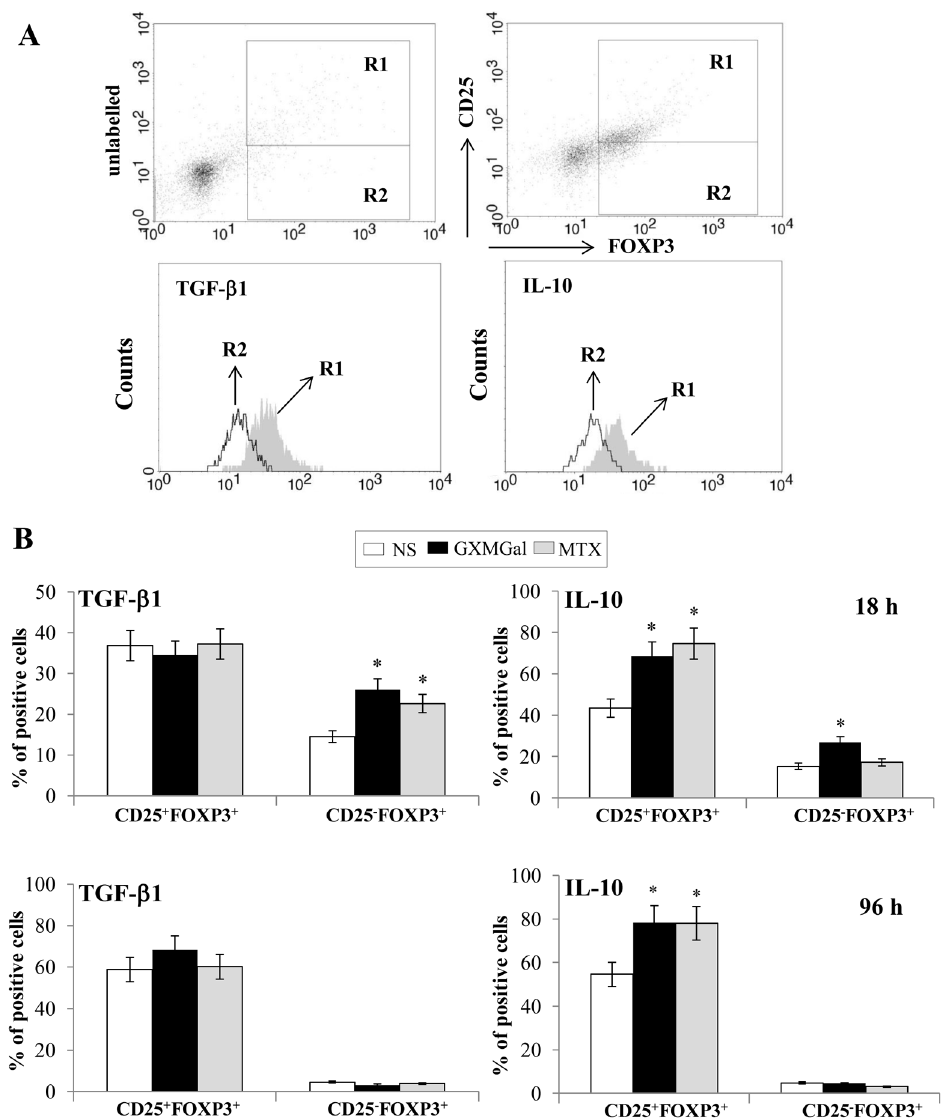
Figure 3. GXMGal effect on Treg cell intracellular cytokines production. Activated purified CD4 + T cells (1 6 10 6 /ml) from RA were incubated for 18 or 96 h in the presence or absence (NS) of GXMGal (10 m g/ml) or MTX (10 ng/ml). After incubation, cells were stained for cell surface expression of CD25 then intracellular stained for FOXP3 and TGF- b 1 or IL-10. For the analysis of intracellular cytokines, CD25 + FOXP3 + (R1) and CD25 2 FOXP3 + (R2) cells were gated on purified CD4 + T cells. The gating strategy was shown ( A ). The percentage of intracellular TGF- b 1 and IL-10 on CD25 + FOXP3 + and CD25 2 FOXP3 positive cells were shown after 18 h or 96 h ( B ) as mean 6 SEM of ten independent experiments. *, p , 0.05 (triplicate samples of 10 different RA; treated vs untreated